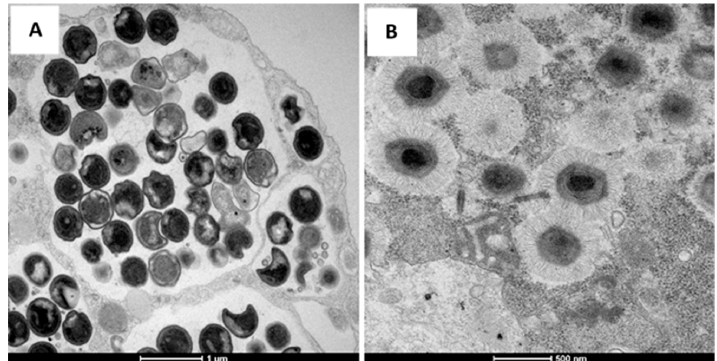
Figure 1. Transmission electron microscopy of the Chlamydia bacterium ( A ) and Mimivirus ( B ).